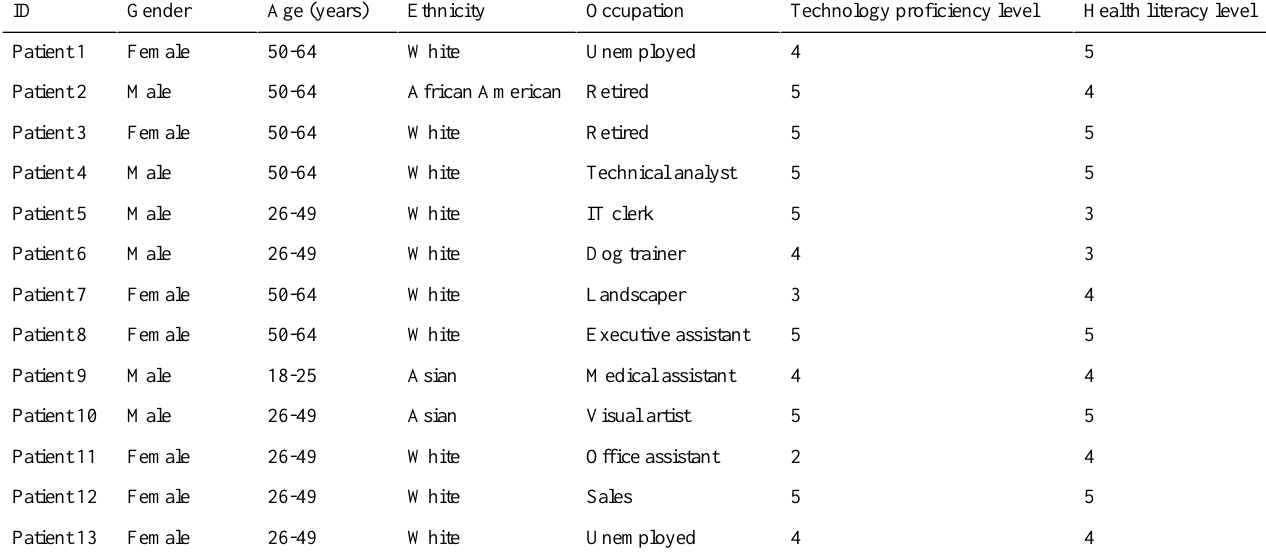
Table 3. Characteristics of interview